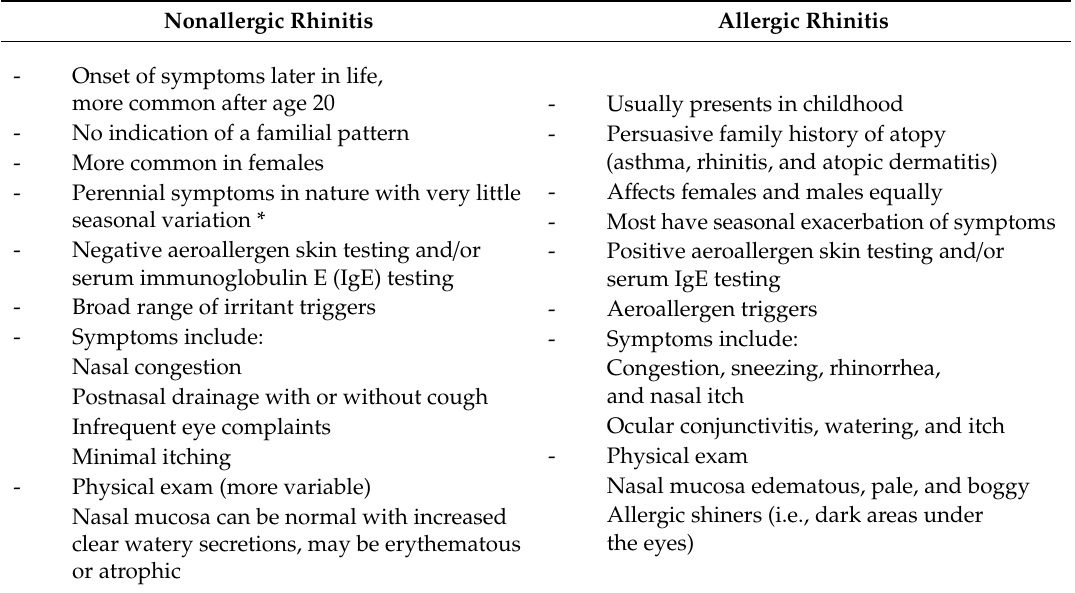
Table 2. Distinguishing features of nonallergic rhinitis and allergic rhinitis